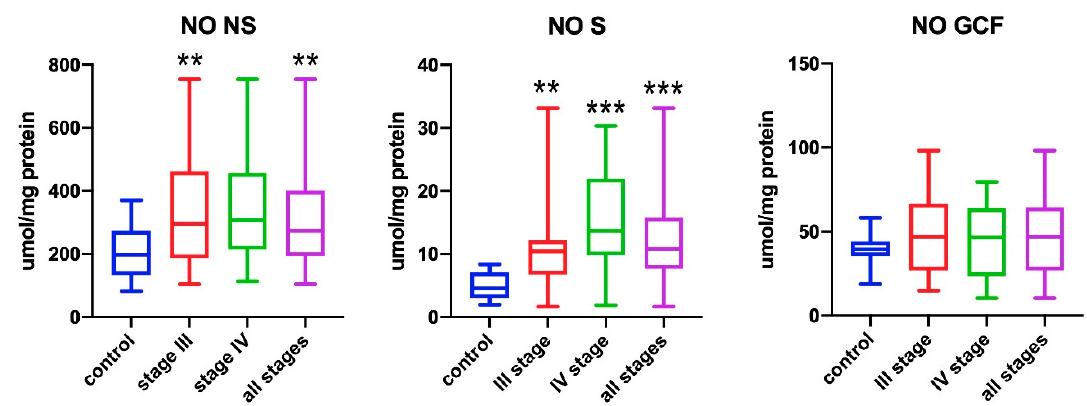
Figure 1. Concentrations of nitric oxide (NO) in non-stimulated saliva (NS), stimulated saliva (S), and gingival crevicular fluid (GCF) in all patient groups. ** p < 0.01 *** p < 0.001 versus control group.